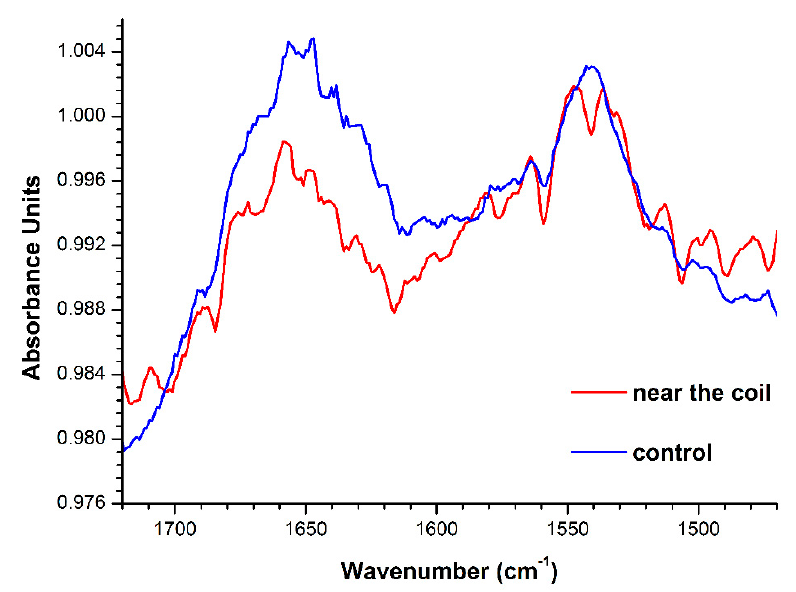
Figure 5. Attenuated total reflection Fourier-transform infrared spectroscopy (ATR-FTIR) spectra obtained for 10 − 4 M HRP solutions, which were incubated either near the coil with flowing water (red line) or at a 10 m distance from the coil (blue line).